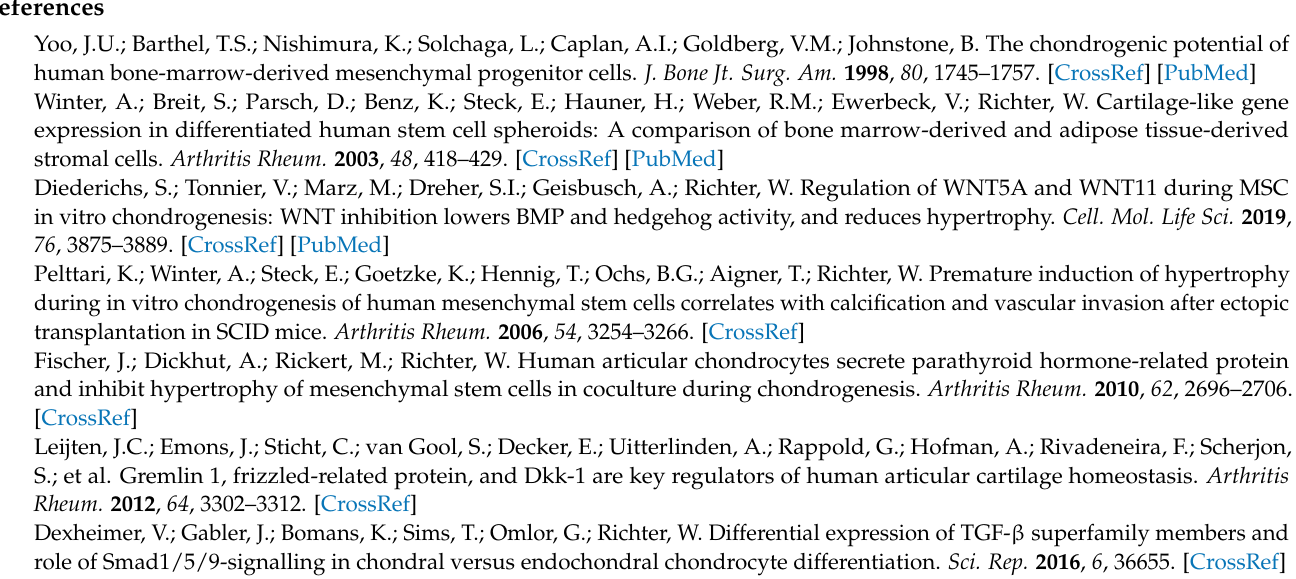
order; Figure S1: Reduction in ALP enzyme activity during MSC chondrogenesis by the BMP inhibitor LDN-21 or the WNT inhibitor IWP-2; Figure S2: AKT inhibition impairs MSC chondrogenesis; Figure S3: Dose-dependent effects of PI3K/AKT inhibition on gene expression of IHH , PTH1R , and ALPL as well as type II collagen deposition; Figure S4: PI3K/AKT signaling is important for TGF β activity and SOX9 protein